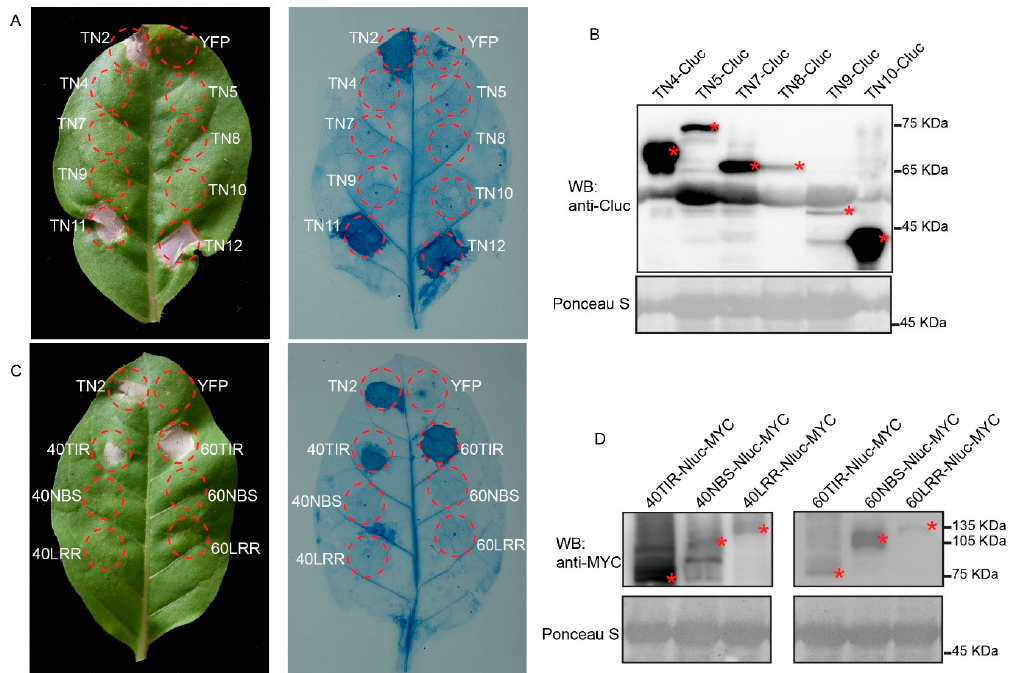
Figure 4. Overexpression of Arabidopsis TN4-TN12 and TNL40/60 canonical domain in N. tabacum leaves. ( A ) Transient overexpression of TN4-Cluc, TN5-Cluc, TN7-Cluc, TN8-Cluc, TN9-Cluc, TN10-Cluc, TN11-Cluc, and TN12-Cluc in N. tabacum leaves and cell death was observed and photographed at 4 days after injection. TN2 was used as a positive control and YFP-Cluc was used as a negative control. ( B ) Immunoblotting analysis of the accumulation of TN4-Cluc, TN5-Cluc, TN7-Cluc, TN8-Cluc, TN9-Cluc, TN10-Cluc proteins in N. tabacum leaves. Asterisks indicate the position of the corresponding proteins. ( C ) Transient overexpression of 40TIR-Nluc-MYC, 40NBS-Nluc-MYC, 40LRR-Nluc-MYC, 60TIR-Nluc-MYC, 60NBS-Nluc-MYC, 60LRR-Nluc-MYC in N. tabacum leaves and cell death was observed and photographed at 4 days after injection. TN2 was used as a positive control and YFP-Nluc was used as a negative control. ( D ) Immunoblotting analysis of the accumulation of 40TIR-Nluc-MYC, 40NBS-Nluc-MYC, 40LRR-Nluc-MYC, 60TIR-Nluc-MYC, 60NBS-Nluc-MYC, 60LRR-Nluc-MYC proteins in N. tabacum leaves. Asterisks (*) indicate the position of the corresponding proteins.